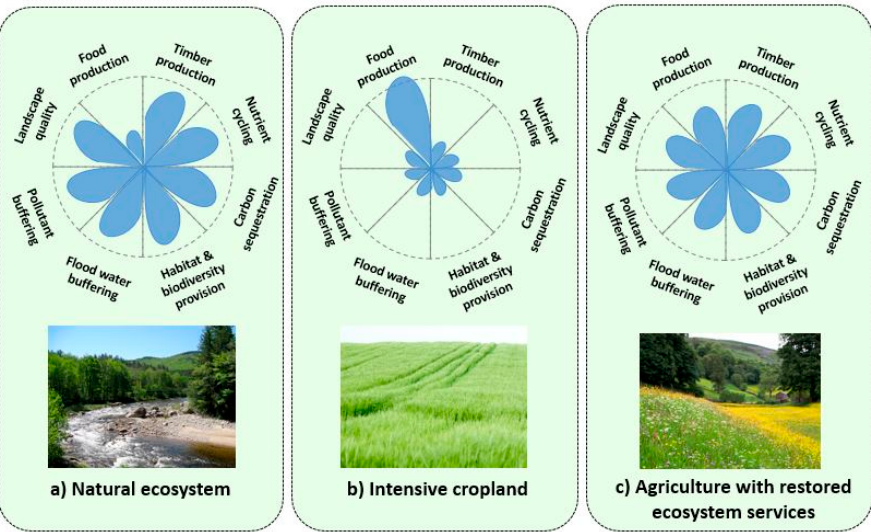
Figure 1. ‘Flower diagrams’ illustrating multiple ecosystem service provision under